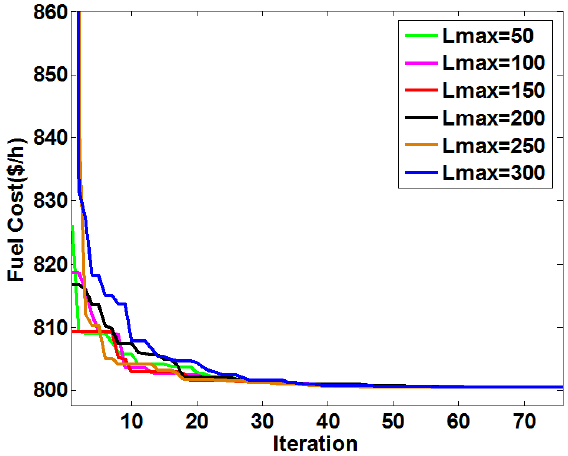
Figure 6. Convergence characteristics obtained by the IABC algorithm with different L max parameter values for OPF with total fuel